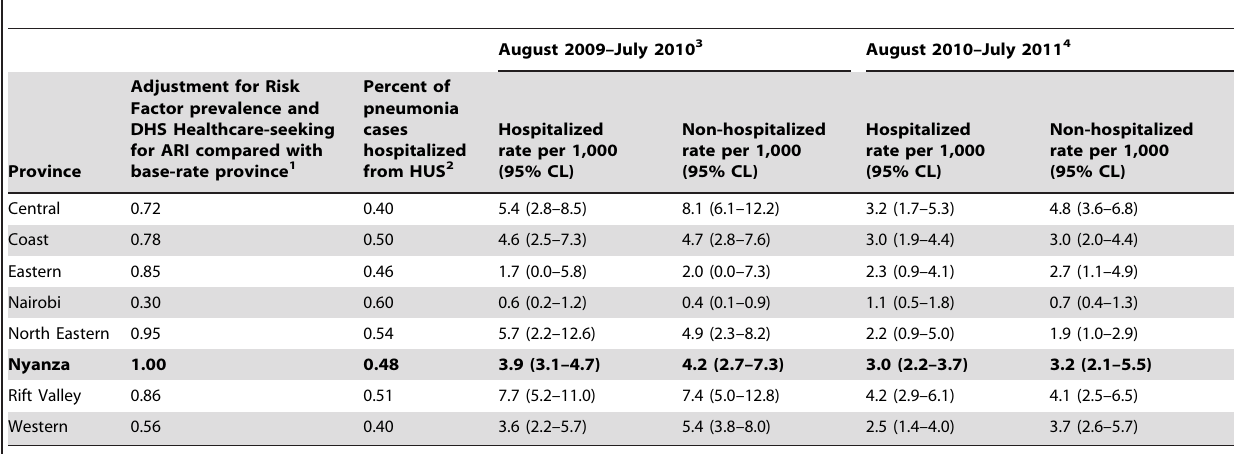
Table 2. Rate (per 1,000) and 95% confidence limits of influenza-associated severe acute respiratory illness (SARI) among children , 5 years of age in Kenya, August 2009 to July 2011, using the Karemo division denominator (see